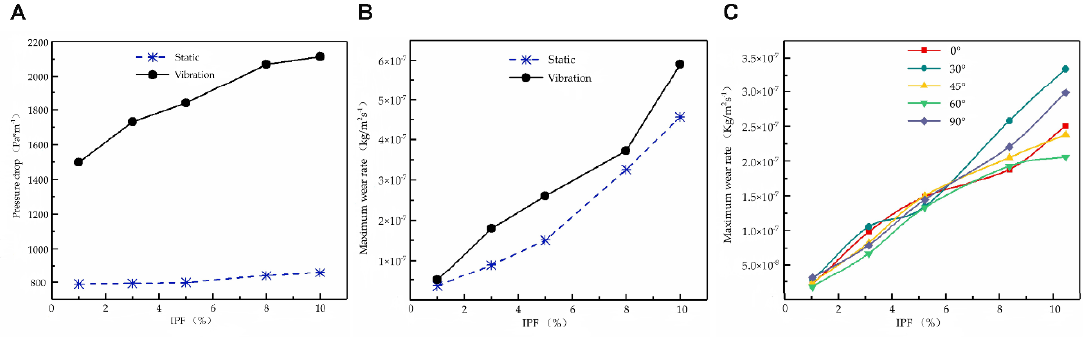
Figure 8. The effect of IPF on pressure drop ( A ), and maximum wear rate at each angle section of elbow ( B , C